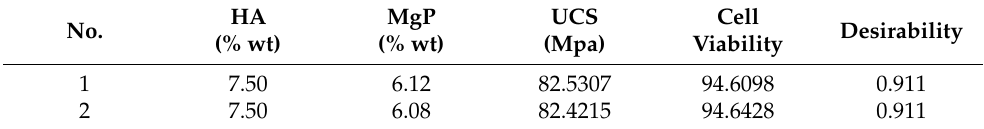
Table 8. The solution for optimization. Table 7. The confirmation tests for cell viability.